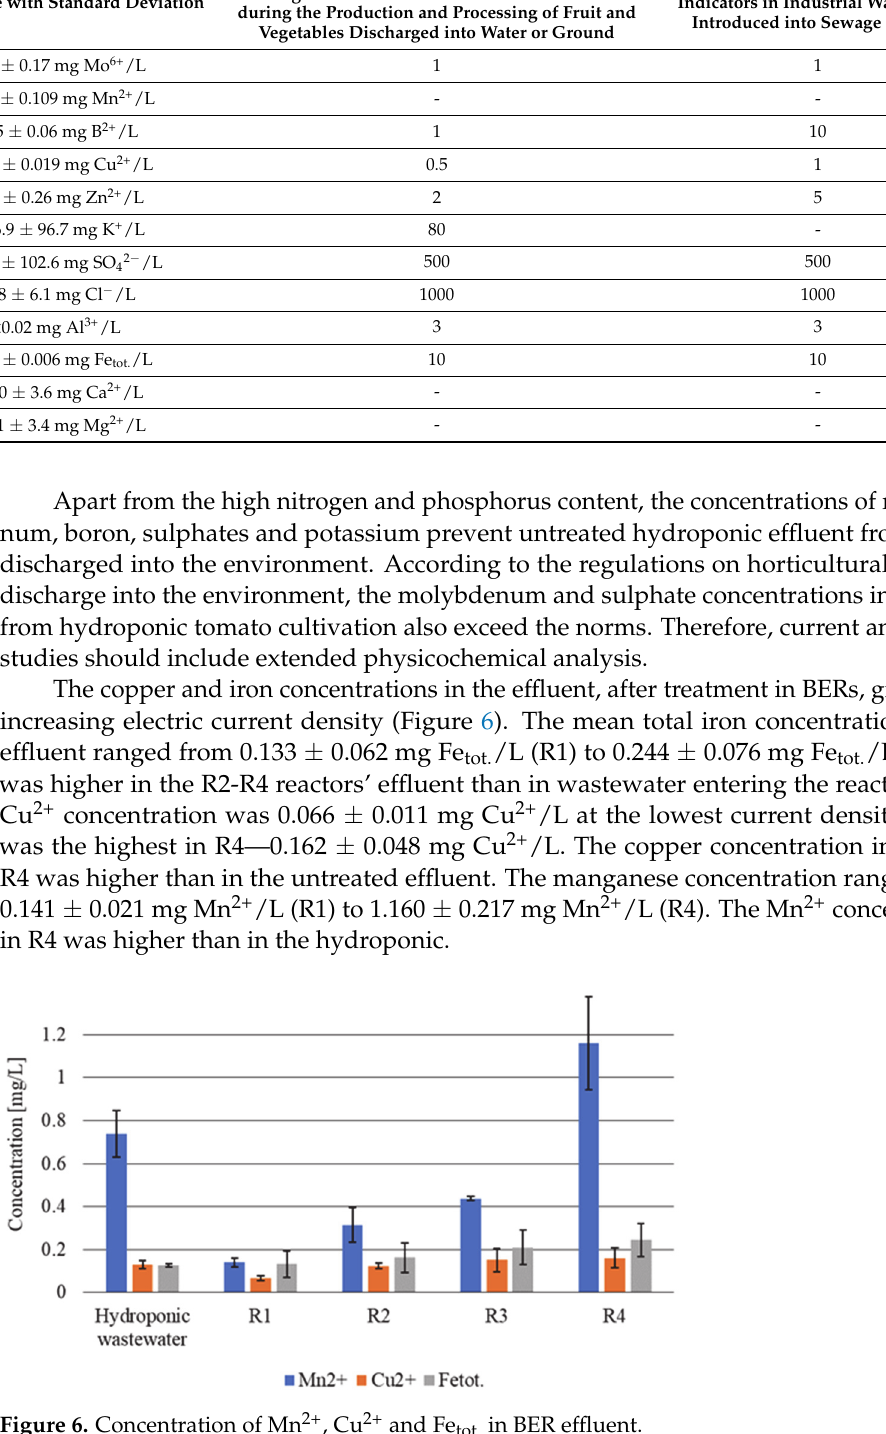
14.0 mg Mo 6+ /L and 116.7 ± 6.9 mg Mo 6+ /L, respectively. It was much higher than in the